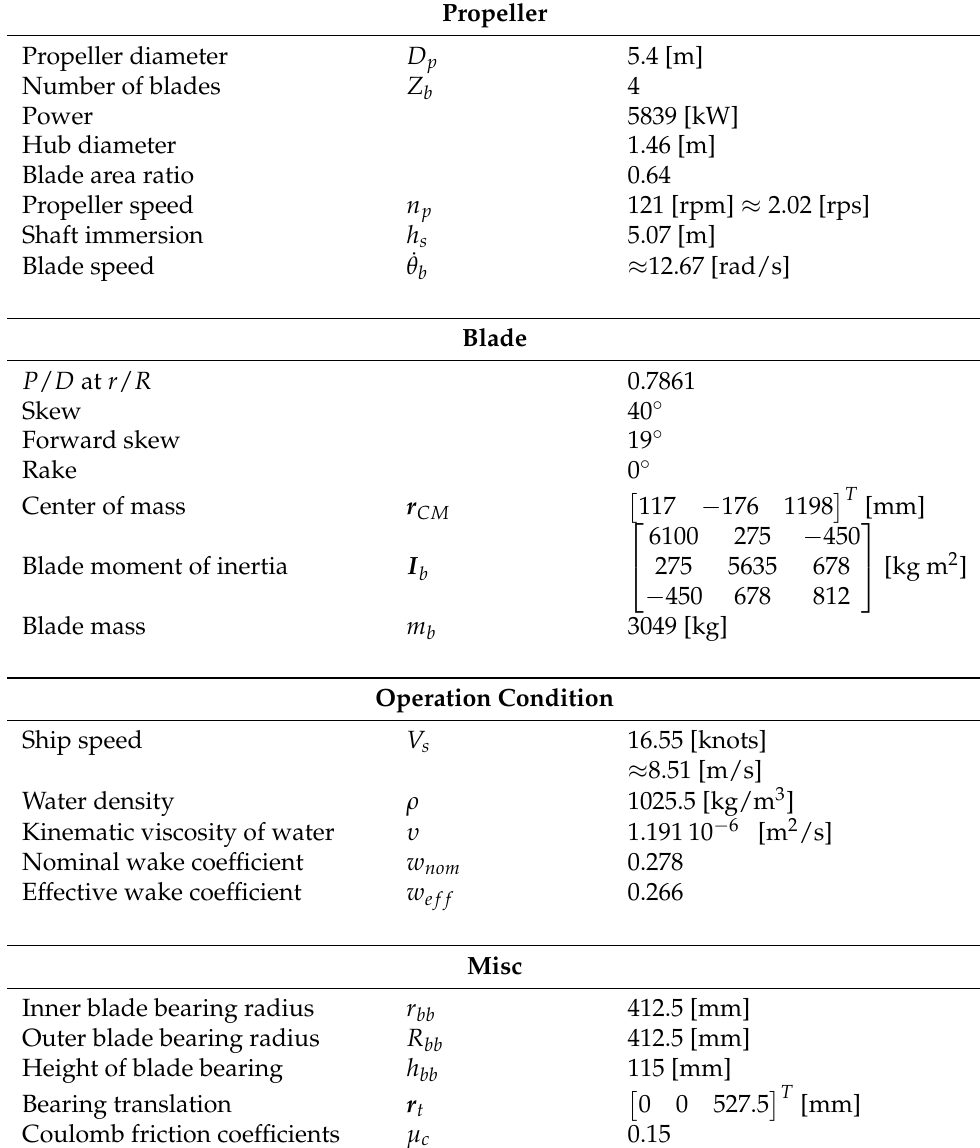
Table A1. Parameters used to model the loads acting on the CVP propeller blades in the considered